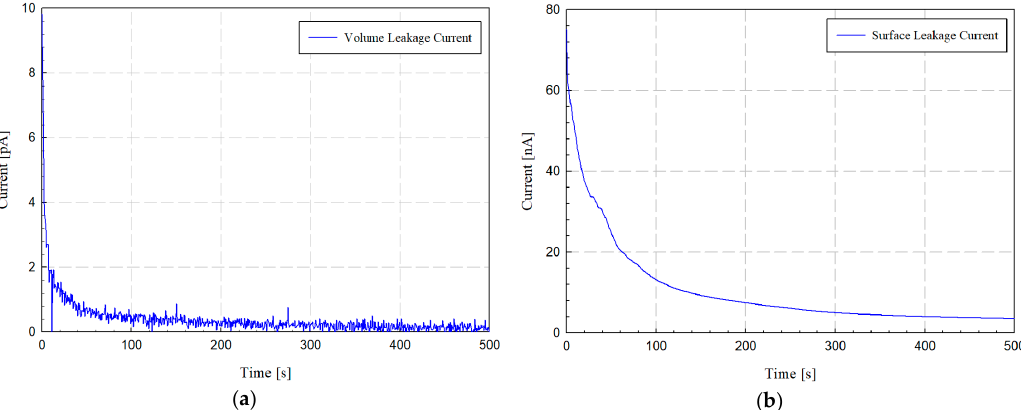
Figure 10. Volume and surface leakage current time characteristics obtained for the PP ( a ) volume leakage current; ( b ) surface leakage current.